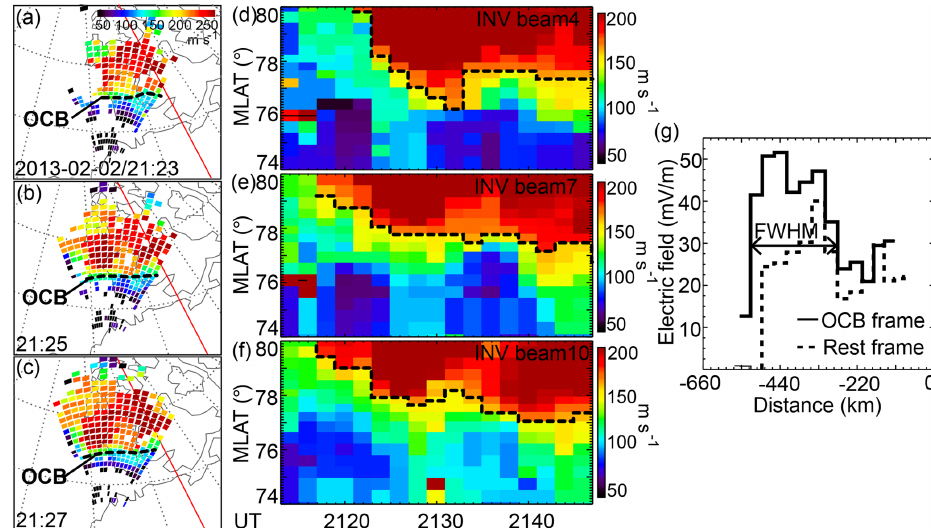
Figure 3. (a–c) Snapshots of spectral width measurements around the space–ground conjunction time and longitude. The open–closed field line boundary is shown as a dashed black line. (d–f) Time series of the spectral width measurements along INV beams 4, 7, and 10 as a function of latitude, from which the motion of the open–closed field line boundary can be derived. (g) The electric field along the open–closed field line boundary in the frame of the boundary (solid) and in the rest frame (dashed) following Pinnock et al. (2003), Freeman et al. (2007), and Chisham et al. (2008). The former is the reconnection electric field.